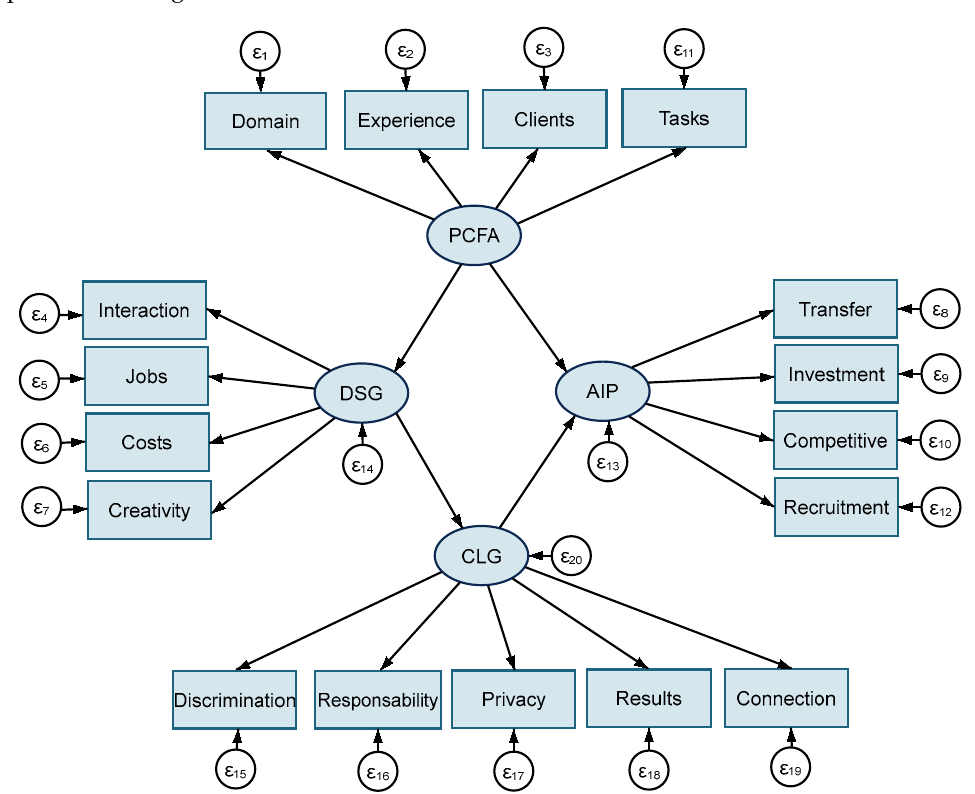
Figure 1. Configuration of the structural equation model (SEM). Source: Authors’ contribution in Stata 13.0.